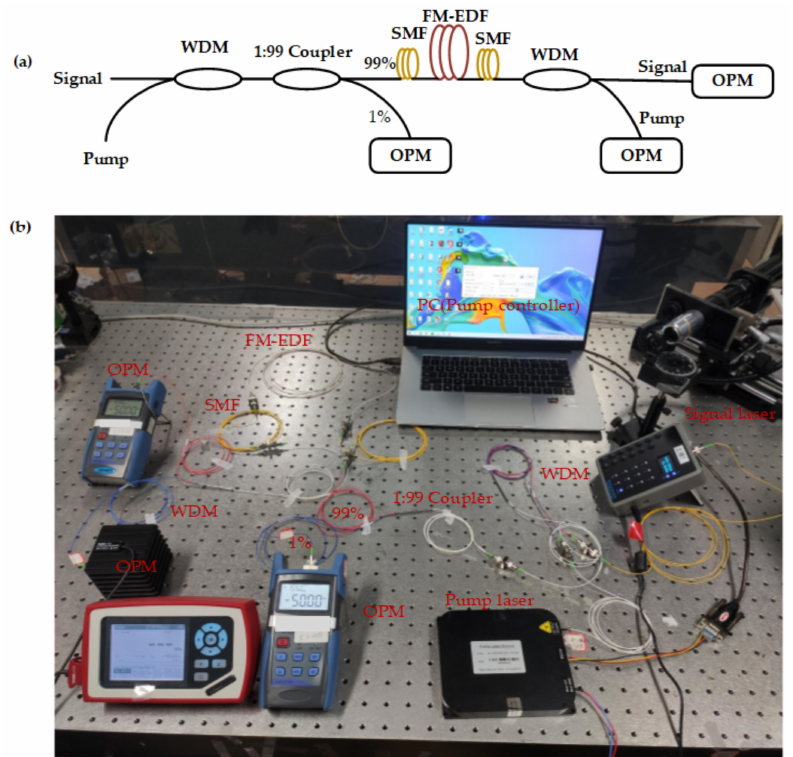
Figure 1. The configuration and photo of the experimental setup: ( a ) the configuration; ( b ) an image of the